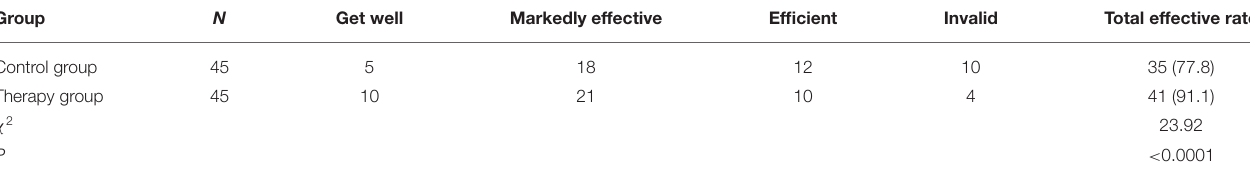
TABLE 4 | Comparison of clinical efficacy between the two groups of patients [ n (%)].